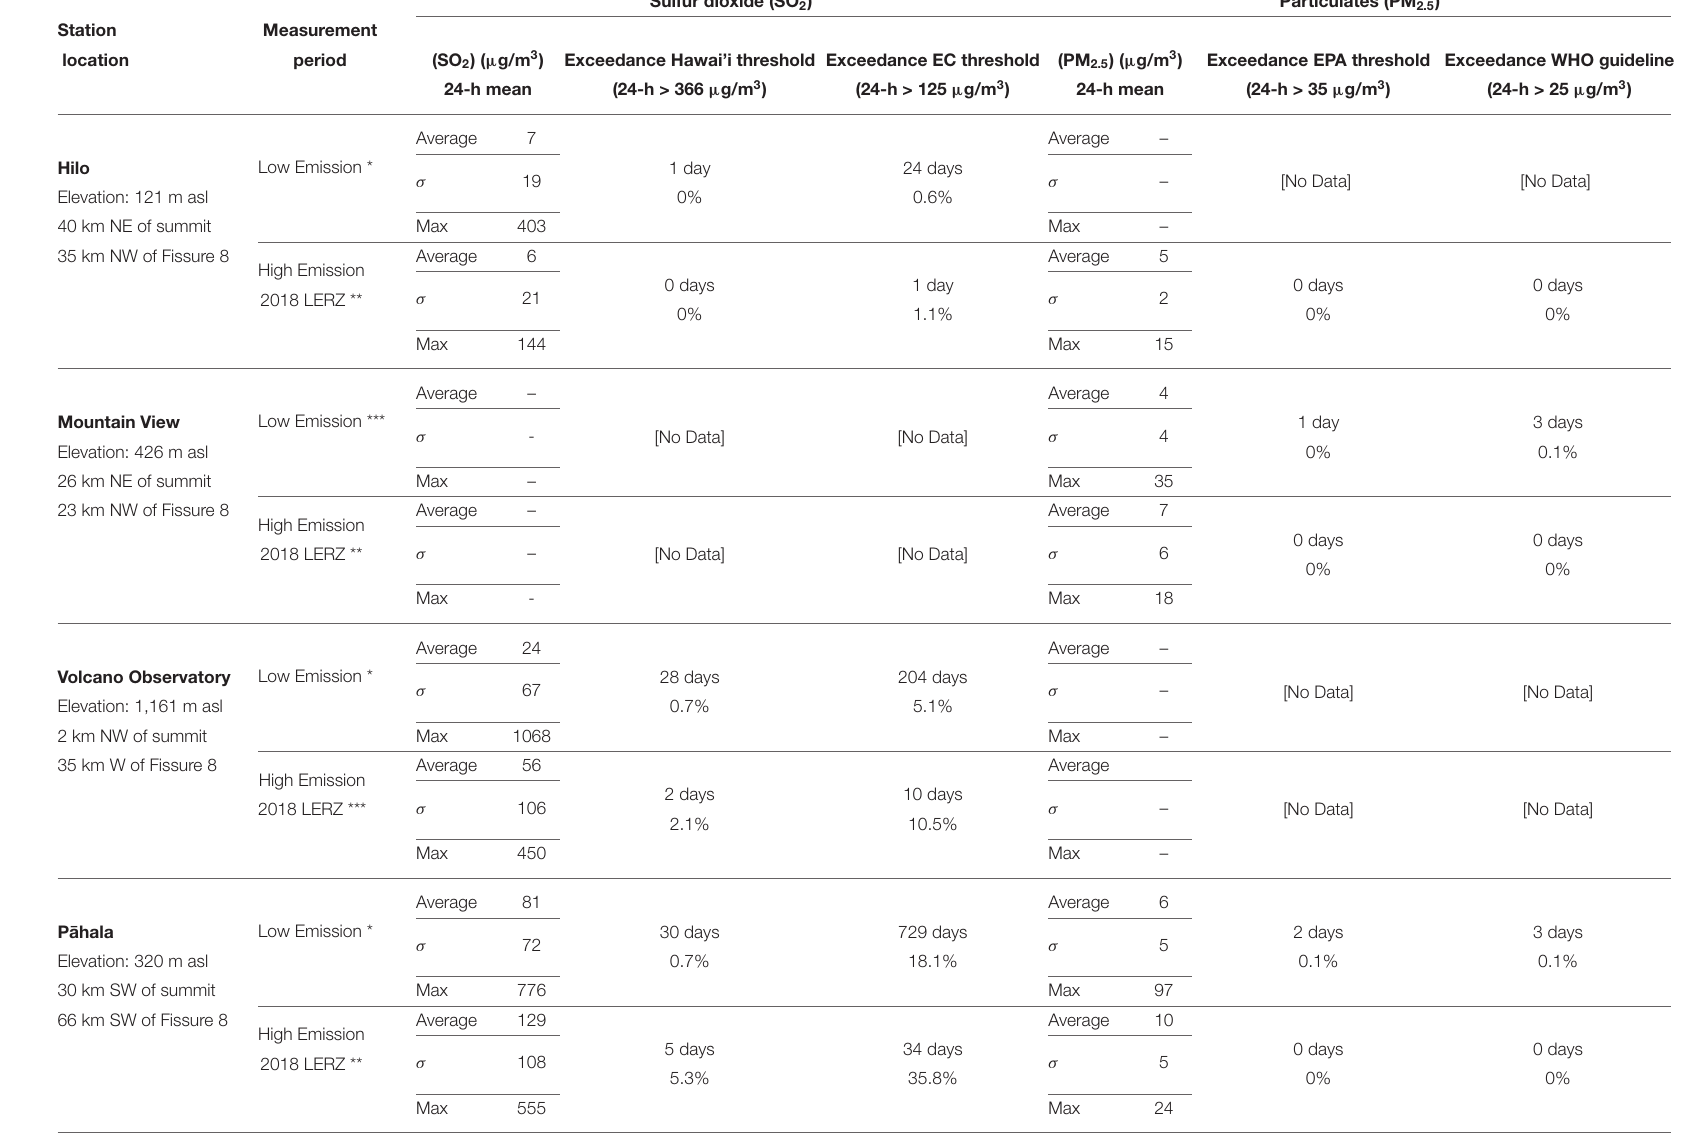
TABLE 1 | Impact of the 2018 LERZ eruption on concentrations of SO 2 and PM 2.5 .